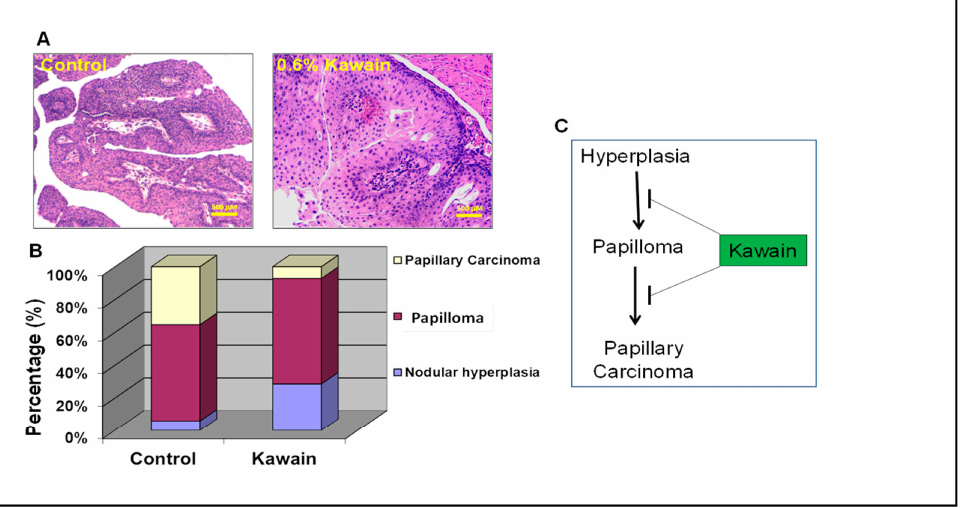
Figure 2. Kawain diet inhibits UCC evolution from hyperplasia to papillary carcinoma. ( A ) Mi- croscopic examination of bladders of male UPII mutant Ha-ras mice fed with indicated experiment diet for five months. Magnification: 100×. ( B ) Percentages of papillary hyperplasia, nodular hyper- plasia, papilloma, and papillary carcinoma of male UPII mutant Ha-ras mice fed with indicated diet for five months as shown in the figure. ( C ) Schematic presentation of the effect of kawain diet on the pathological progression of urothelial cell